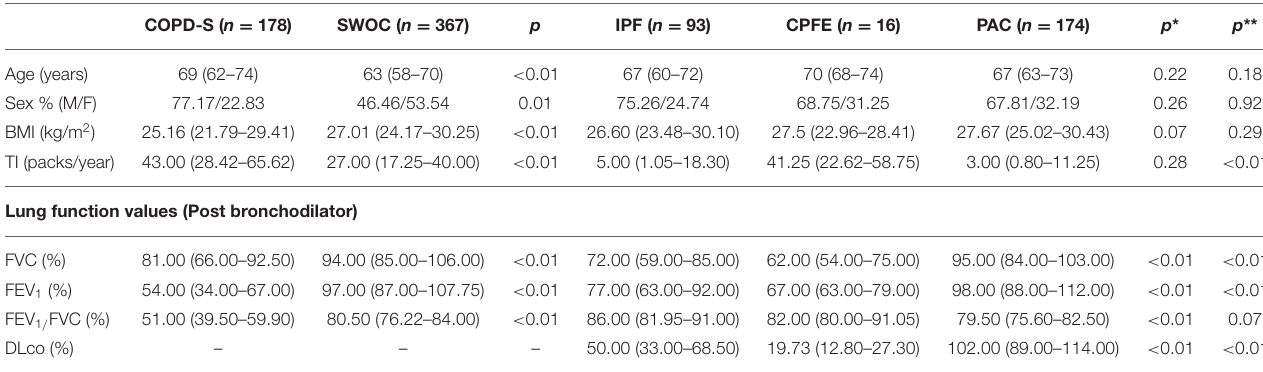
TABLE 1 | Comparison of demographic variables between COPD patients vs. SWOC subjects; IPF patients vs. PAC subjects; CPFE patients vs. PAC subjects.